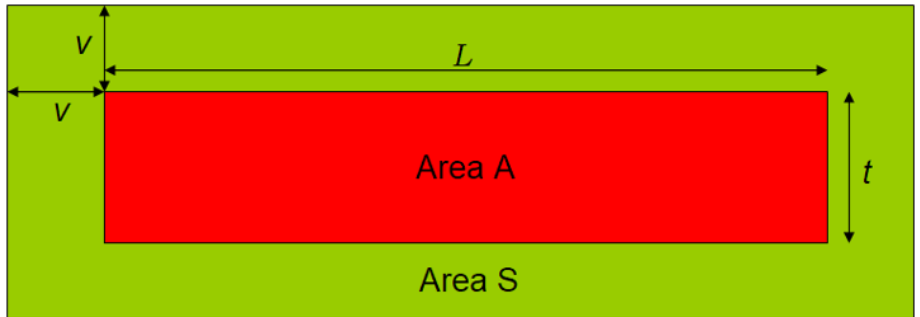
Figure A1. A diagram depicting the area of an ionogram signal (Area A) and its labeling area (Area